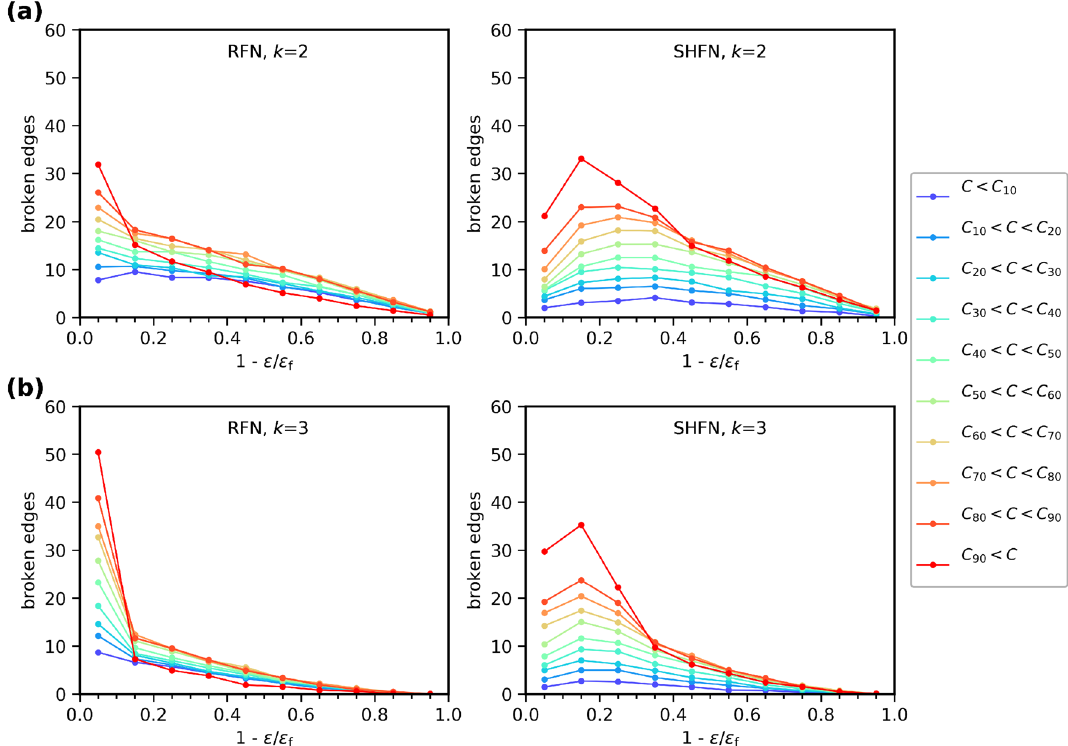
Figure 7. Edge failure predictions for RFN and SHFN, based on current values of GEBC. Number of broken edges as a function of the reduced strain-to-failure variable, for systems of size L = 128 . Each curve represents the number of broken edges at every strain-to-failure stage, from the set of edges in the i th percentile of the distribution of GEBC, p ( C ), recorded at the current strain-to-failure stage and reflecting the effects of accumulated damage. Thresholds are Weibull distributed with shape factors k = 2 ( a ) and k = 3 ( b ). Results for k = 9 are not shown, as they do not differ significantly from those in Fig. 6( c